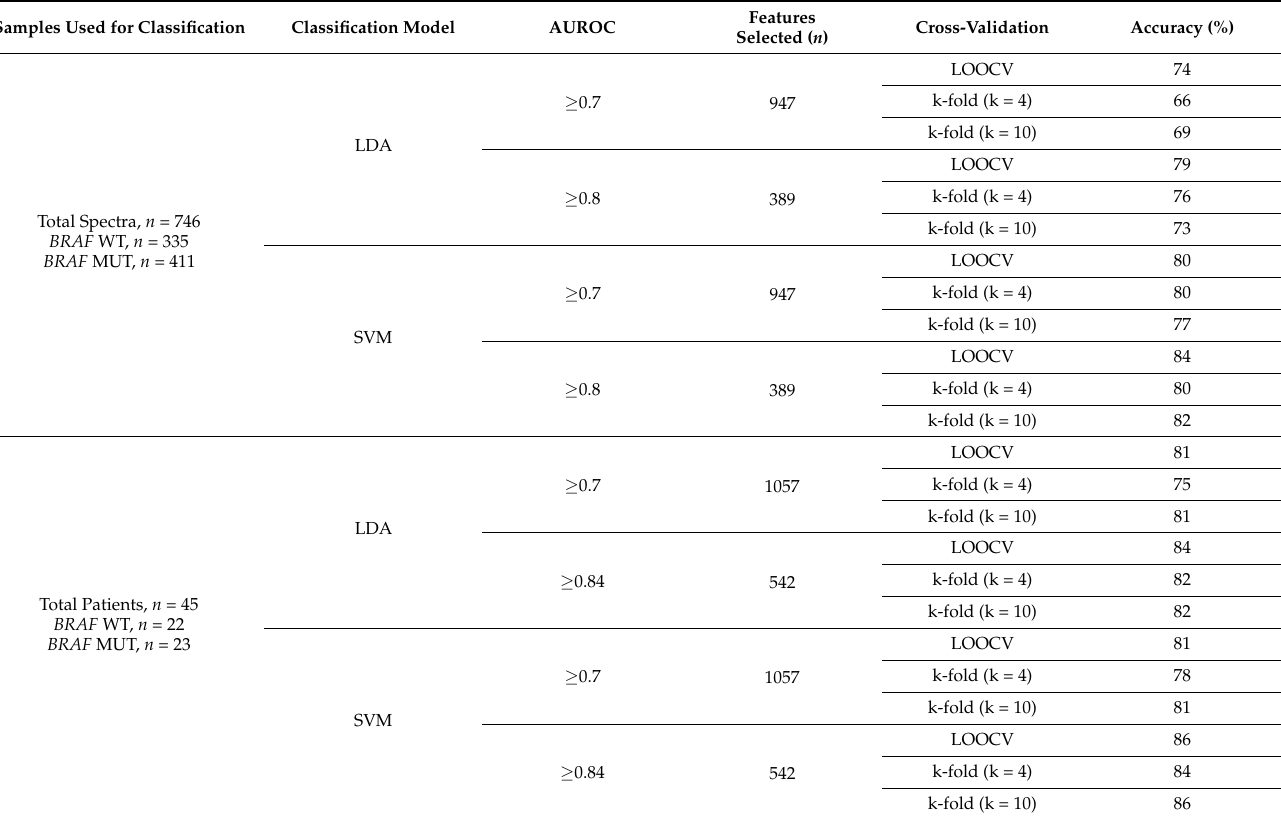
Table 1. Classification analysis to discriminate BRAF (v-raf murine sarcoma viral oncogene